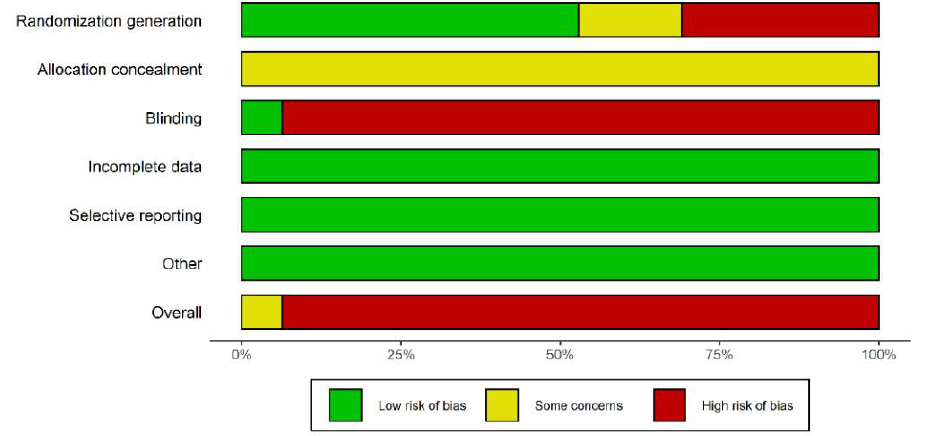
Figure 2. Risk of bias graph.